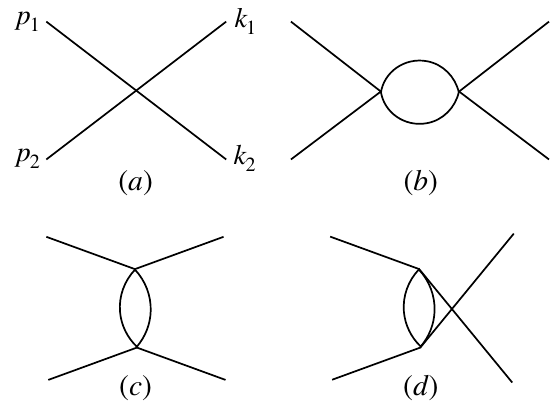
Figure 4. Diagrams contributing to the one-loop two-particle scattering amplitude, M 2